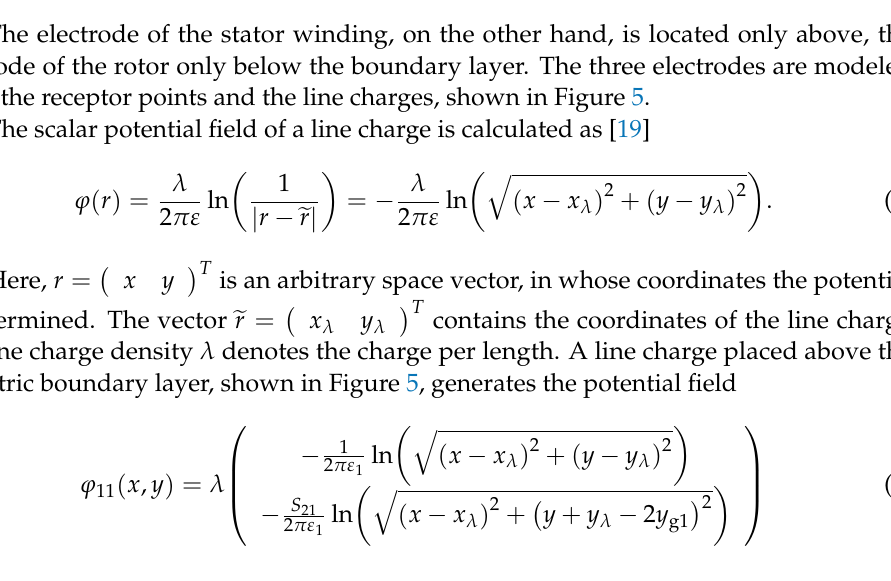
Figure 5. Representation of the electrodes in the slot model under consideration of a dielectric boundary